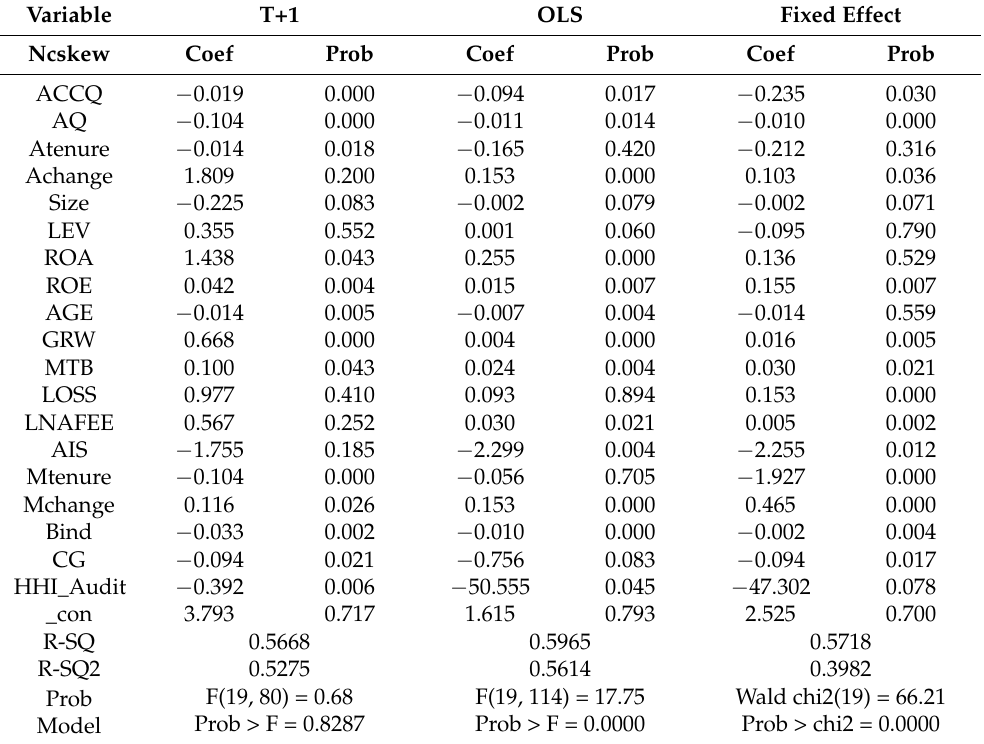
Table 13. The results of the model for